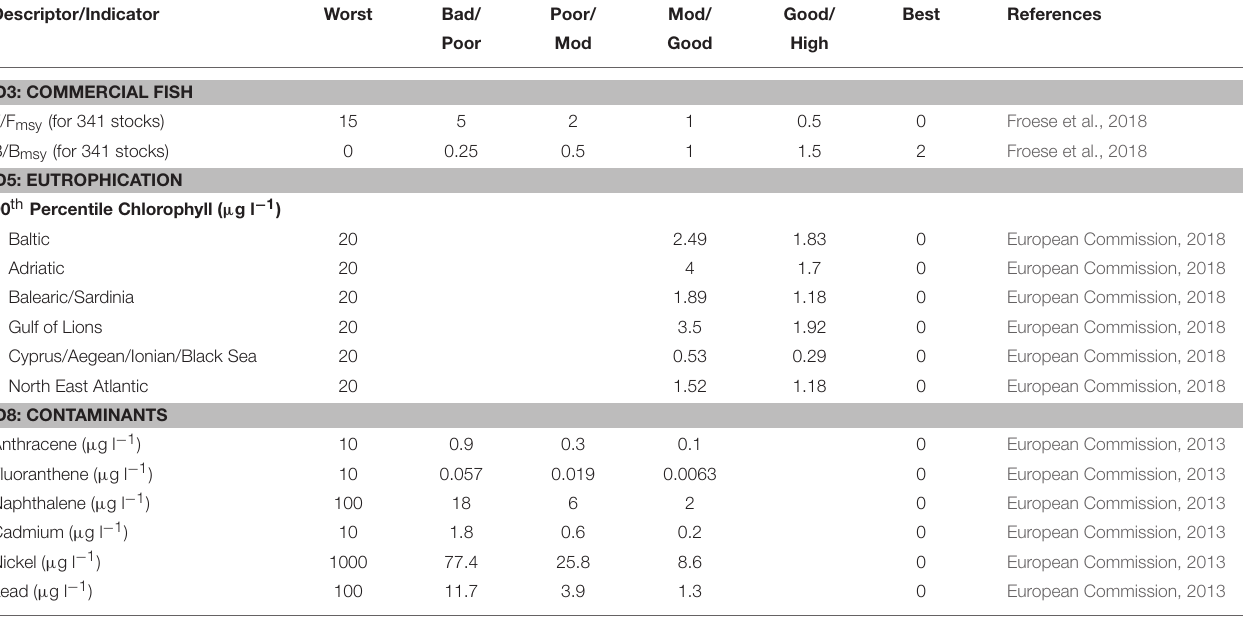
TABLE 2 | Descriptors and indicators used in the analysis, including the range of values and the boundaries or thresholds. Descriptor/Indicator